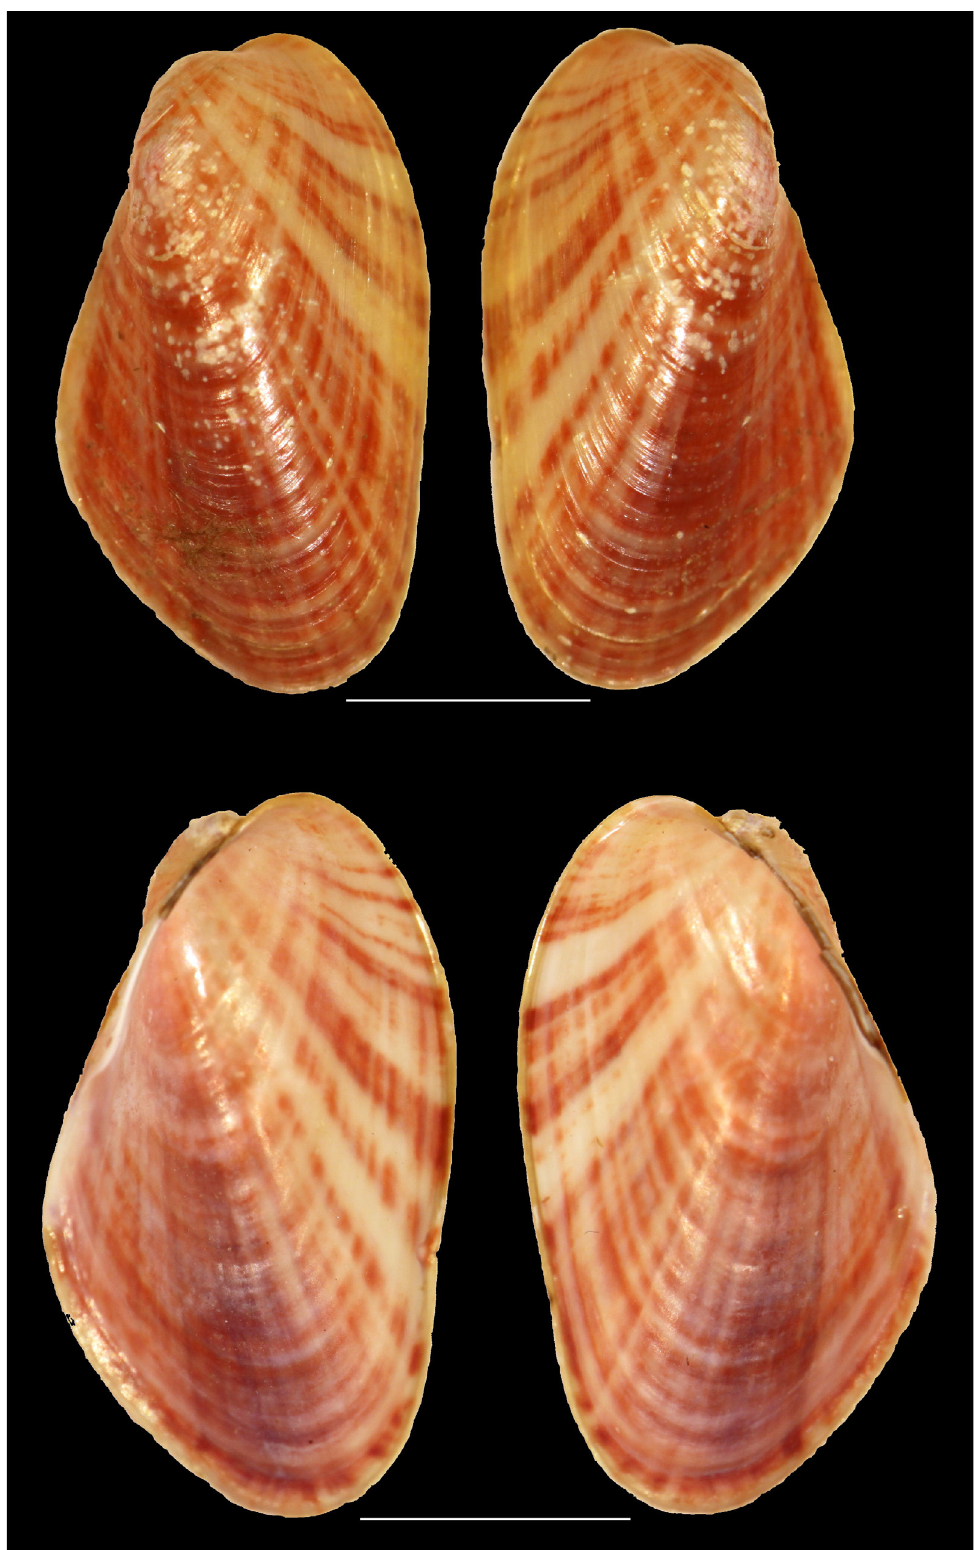
Fig. 1. Modiolus cimbricus sp. nov., holotype (shell length 13.3 mm). The upper part of the figure shows the external shell side and the lower part shows the inner side of the valves. Scale bars = 5